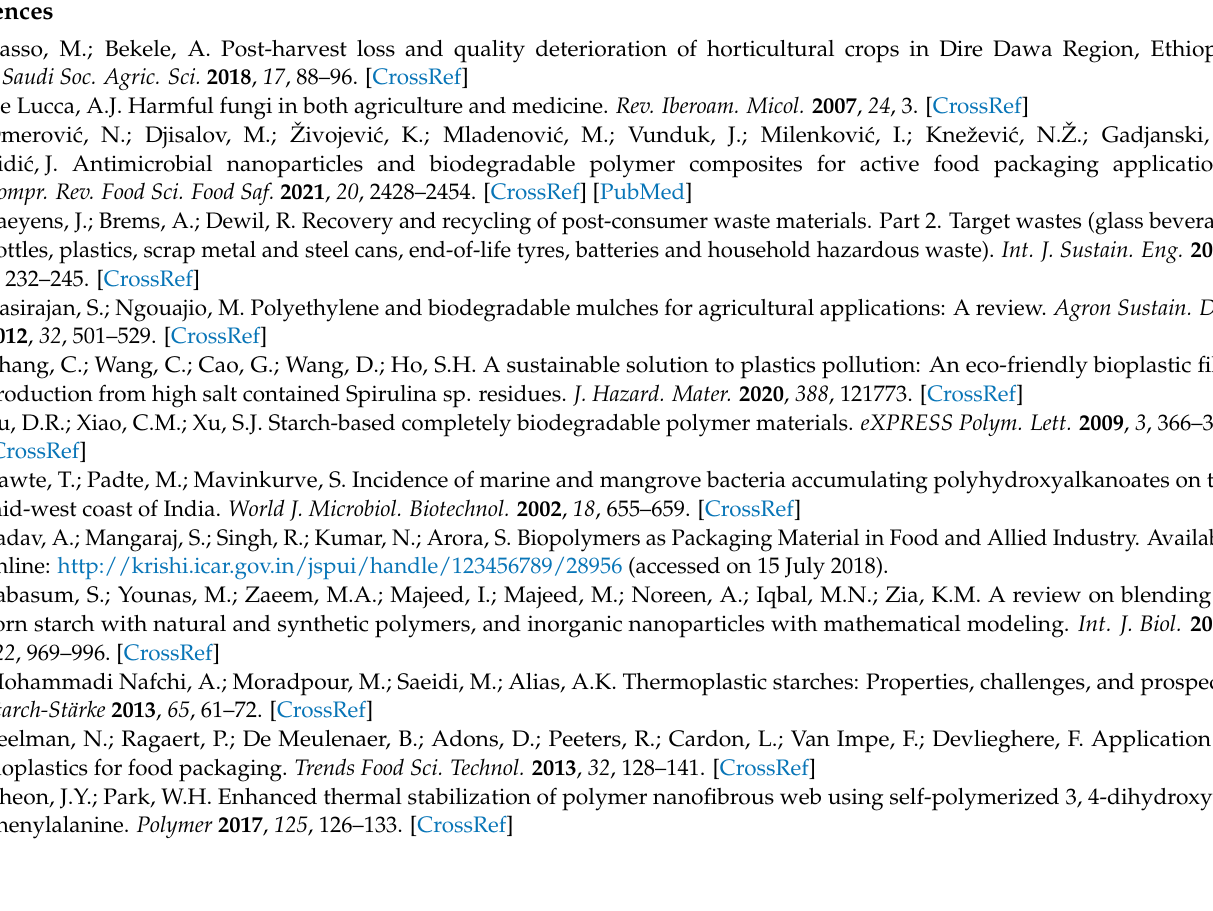
Table S1: MIC and MBC of CuO and ZnO nanoparticles against Klebsiella pneumoniae and Staphylo- coccus